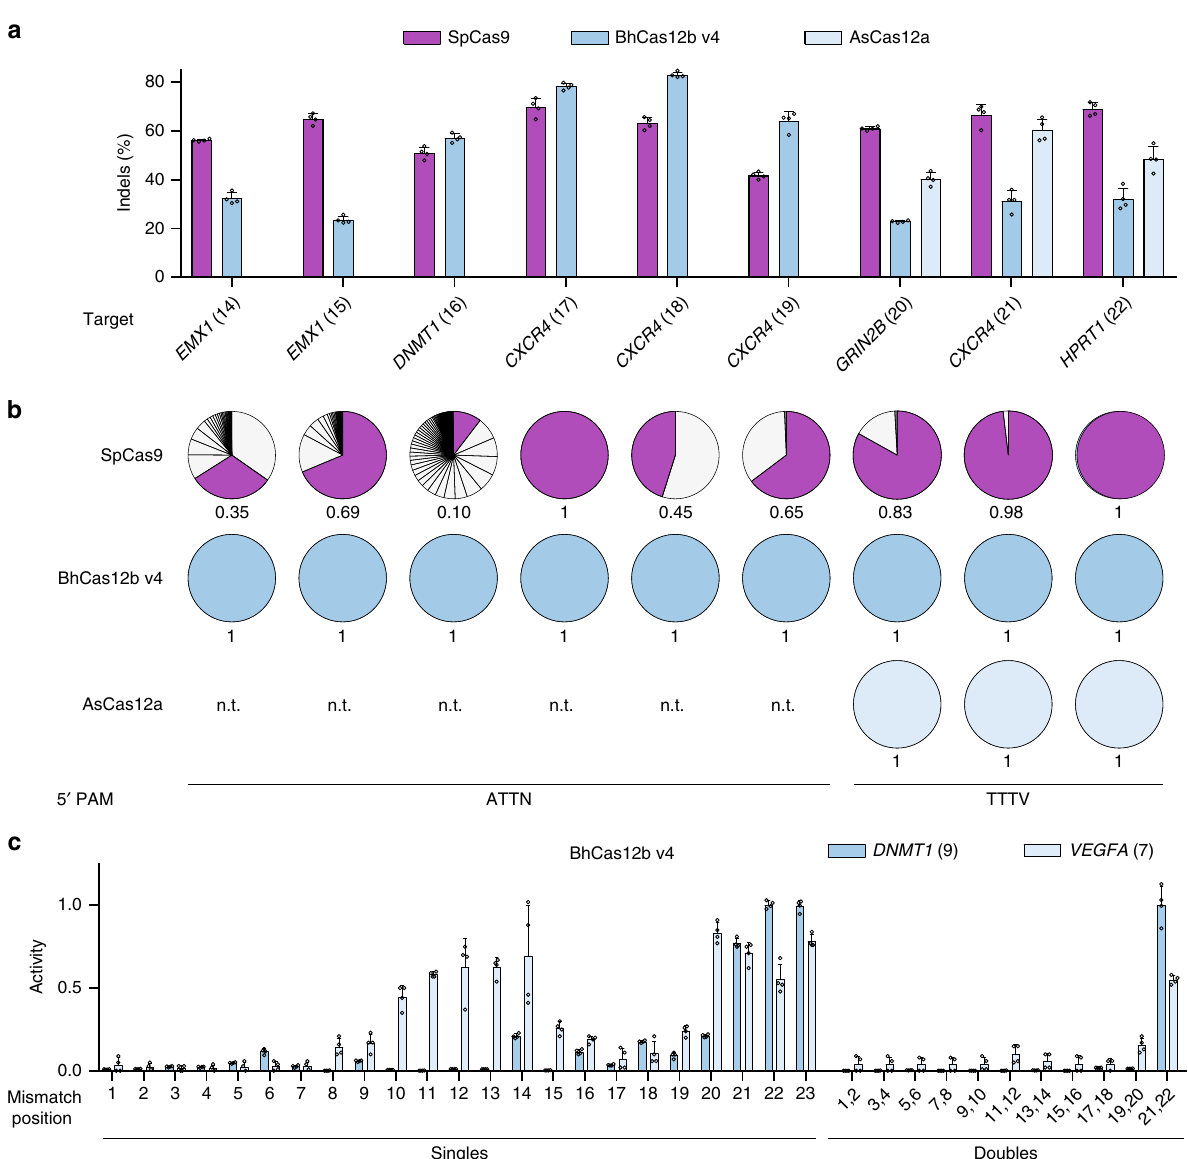
Fig. 4 BhCas12b v4 is a highly speci fi c nuclease. a Comparison of Cas9, Cas12b, and Cas12a indel activity in 293T cells at nine target sites (except for Cas12a, which was only tested at the three TTTV PAM sites) selected for Guide-Seq analysis. Error bars represent s.d. from n = 4 replicates. b Guide-Seq analysis showing the number and relative proportion of detected cleavage sites for each nuclease. Off-targets are shown as light gray wedges, while the on- target site is highlighted in purple (for SpCas9), dark blue (for BhCas12b v4), or light blue (for AsCas12a) with the fraction of on-target reads shown below. Off-targets were only detected with SpCas9. n.t., not tested. See Supplementary Fig. 6 for full analysis. c BhCas12b indel activity in 293T cells when mismatches are present between the guide sgRNA and target DNA. Mismatches were inserted in the sgRNA to match the target strand (i.e., C to G, A to T). Error bars represent s.d. from n = 4 replicates. Source data are provided as a Source Data fi